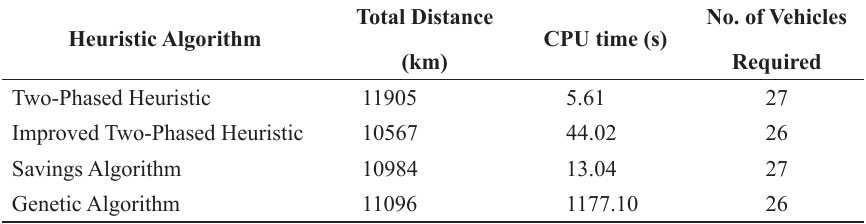
Table 4: Details of the routes generated by the improved two-phased